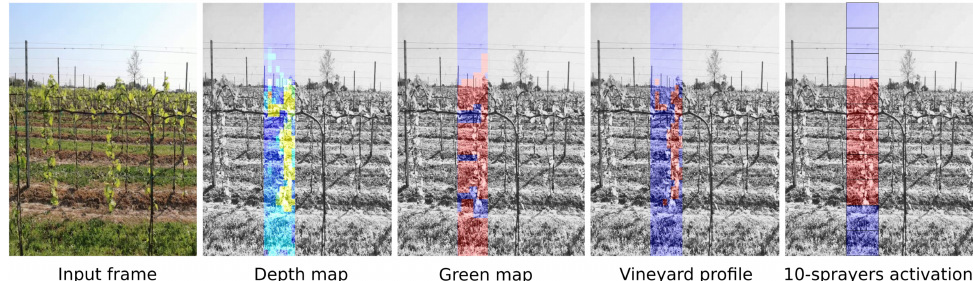
Figure 15. Example frame and respective maps (limited to the ROI covered by the sprayer) of qualitative analysis on video captured in mid-April.